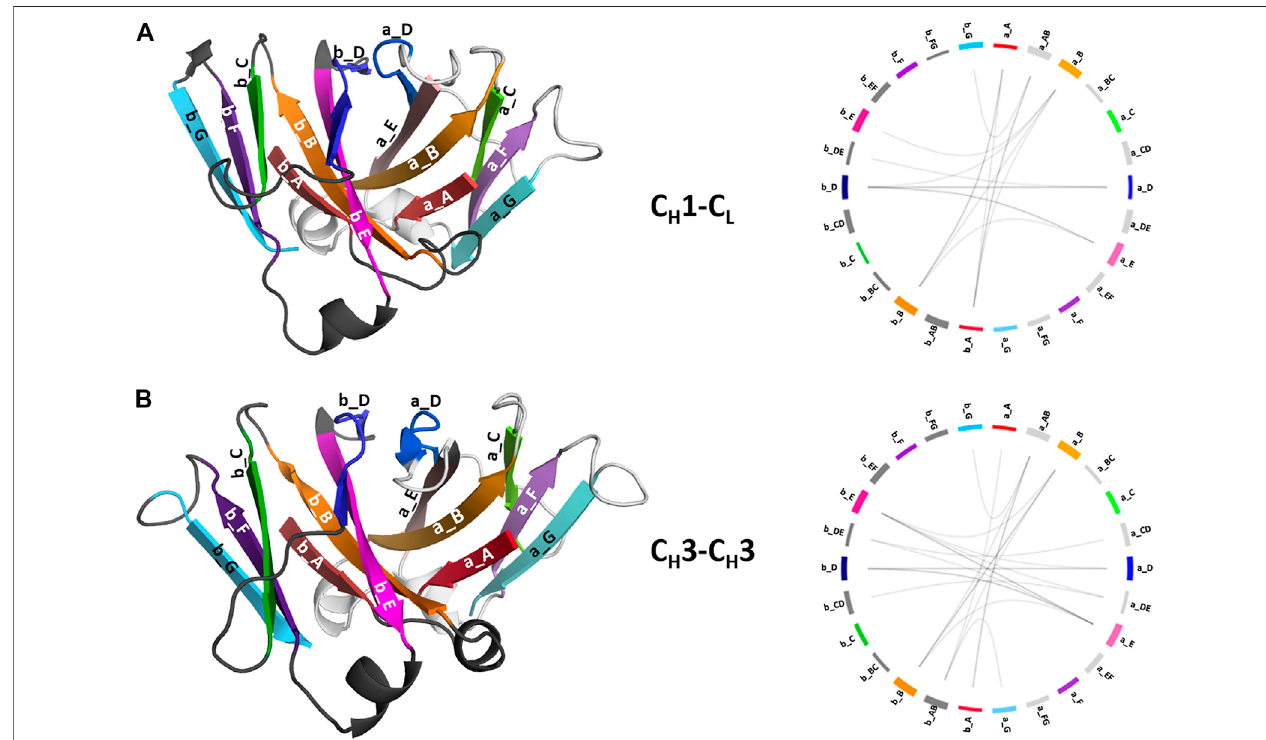
FIGURE 3 | Structural representation of the C H 3-C H 3 and C H 1-C L domains including a coarse-grained contact analysis of the interactions contributing to the formationandstabilizationofthedomaininterfaces. (A) StructureofC C H 3-C H 3 (PDB: 5DJ0) dimer color-coded and labeled according to the coarse-grained fl areplots on the right, which illustrate the interdomain contacts present in the X-ray